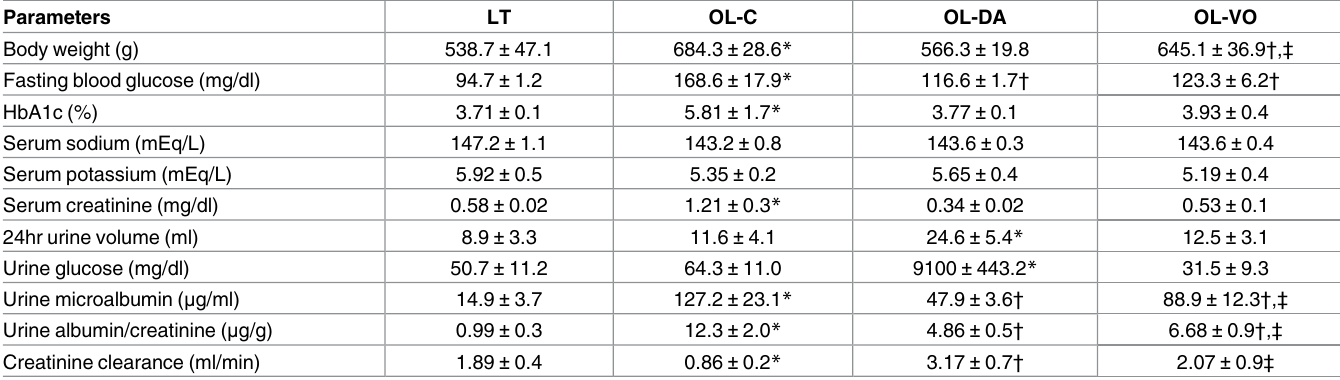
Table 1. Biochemical characteristics after 12 weeks of